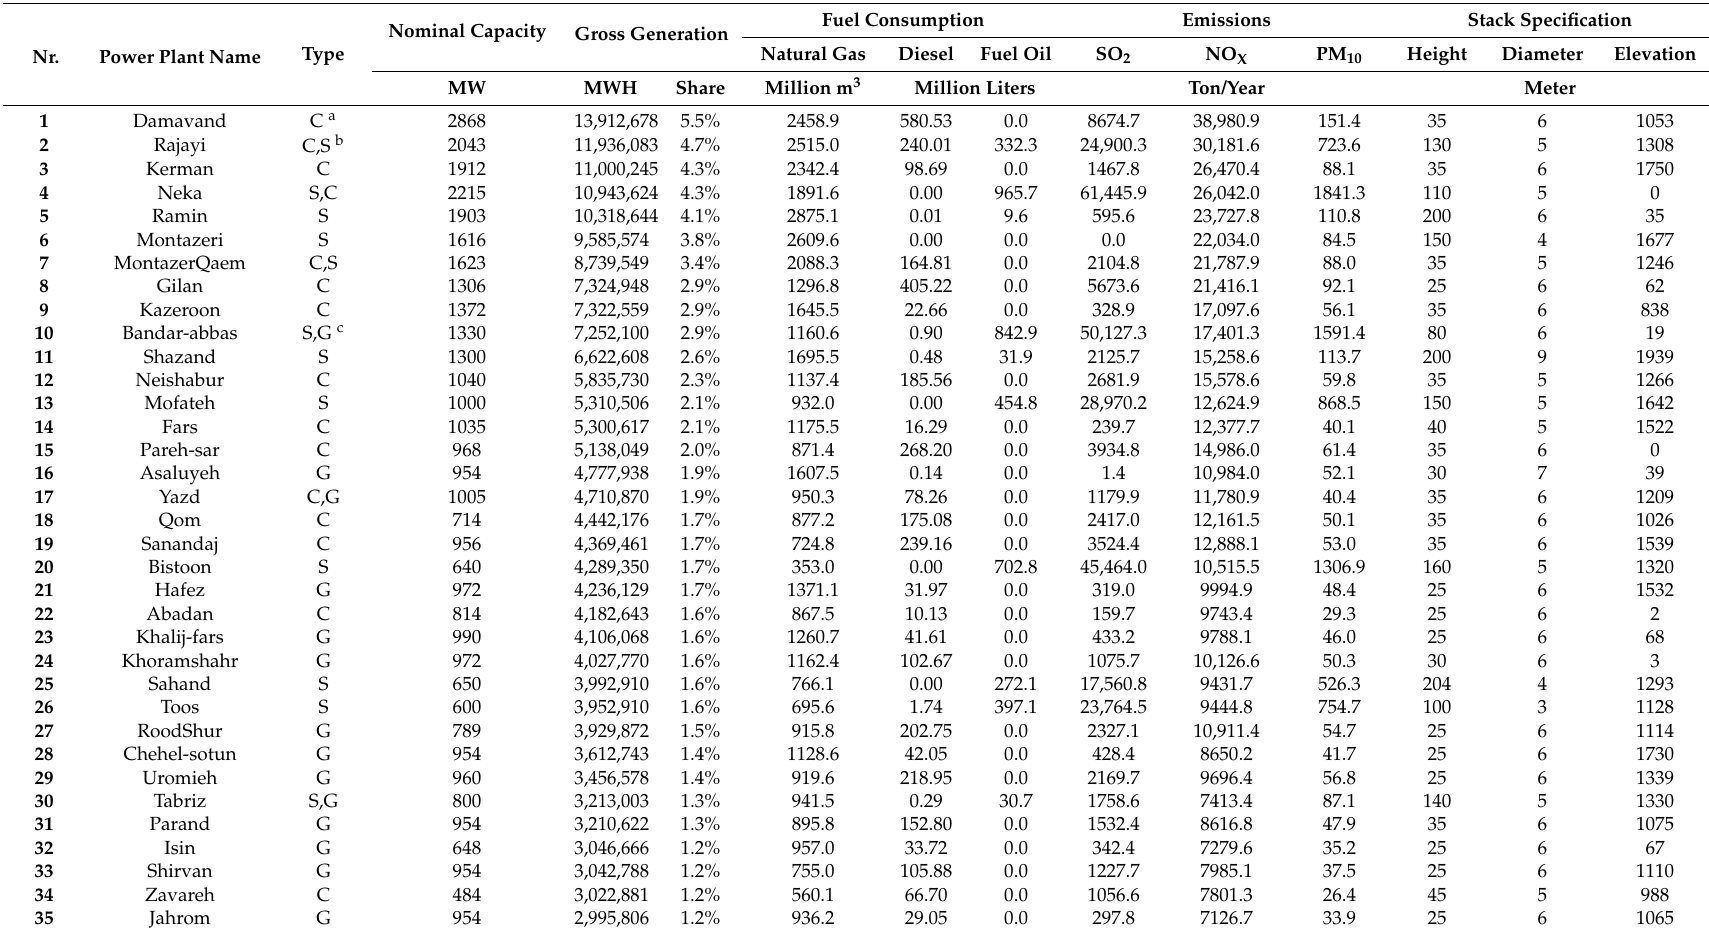
Table A2. The selected power plants characteristics used in the SIMPACTS